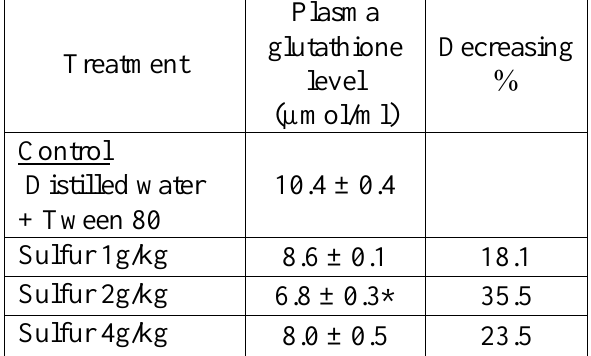
Table 1: Sulfur Effect on the blood level of glucose in the mice: Treated group